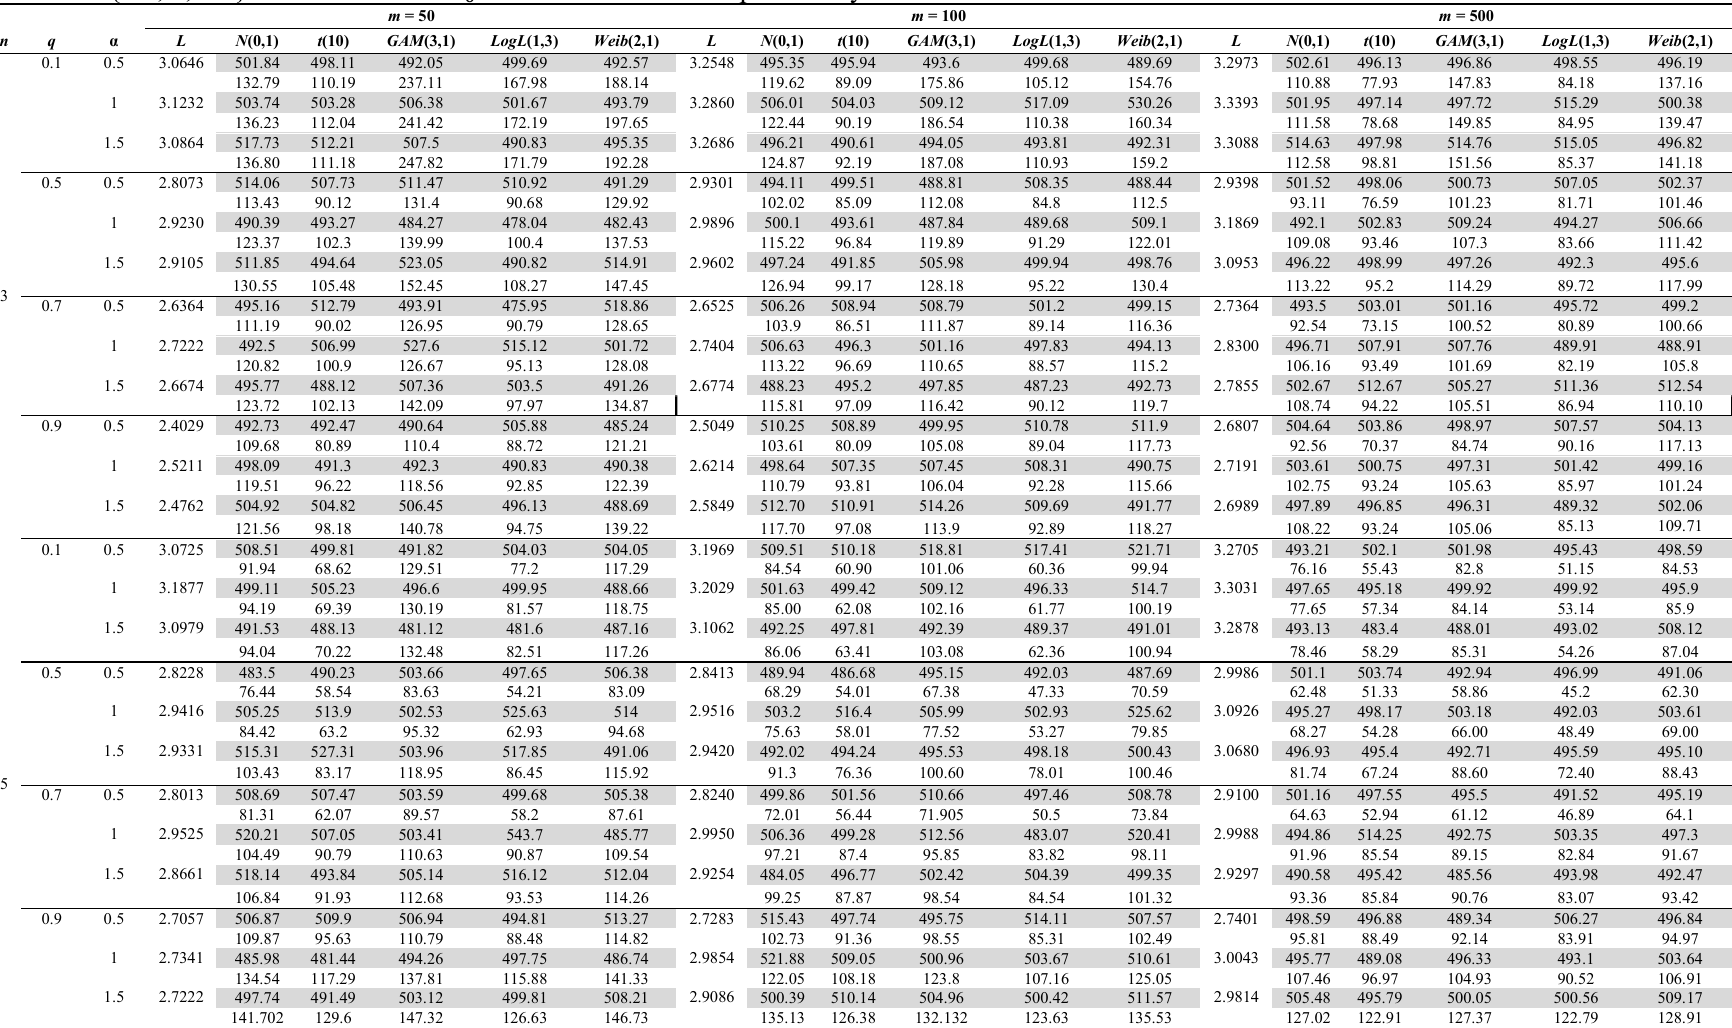
Case A attained 𝐴𝑅𝐿 (first row) and 𝐴𝐸𝑄𝐿 (second row) of the proposed W-GWMA control scheme when 𝑛 ∈ {3, 5}, 𝑚 ∈ {50, 100, 500}, 𝑞 ∈ {0.1, 0.5, 0.7, (cid:2868) 0.9} and 𝛼 ∈ {0.5, 1, 1.5} for a nominal 𝐴𝑅𝐿 of 500 under different probability distribution (cid:2868)